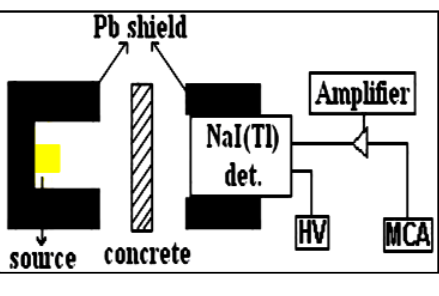
Figure2. Schematic representation of the experimental